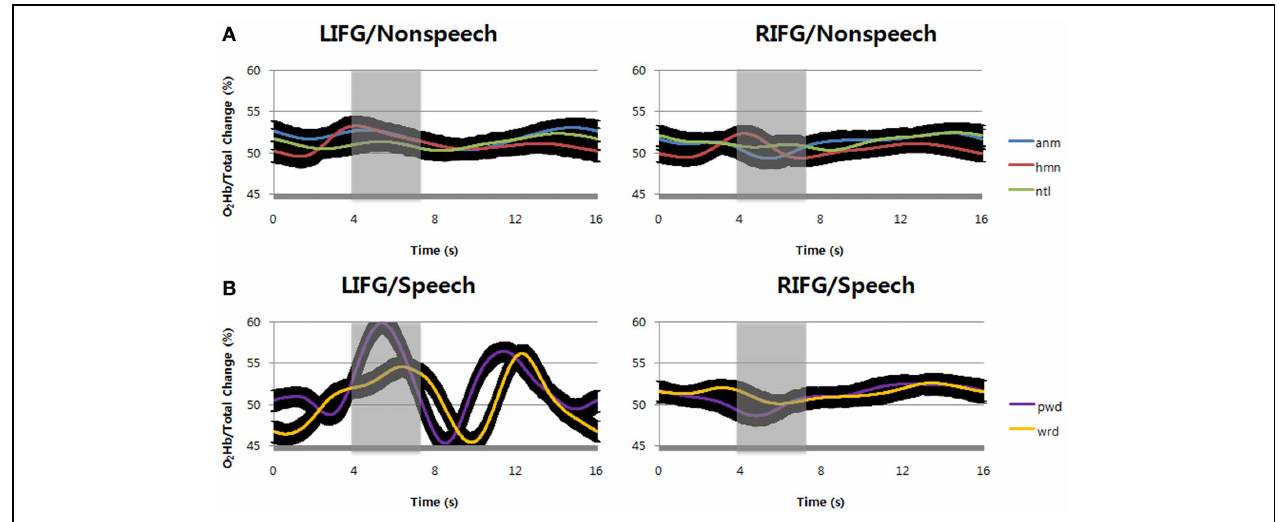
FIGURE 3 | (A) Compared with the value at stimulus onset, the percent change of O 2 Hb over total Hb concentration by passive listening of non-speech sounds, i.e., animal vocalizations, human non-speech sounds, and natural sounds were shown. (B) The percent change of O 2 Hb over total Hb concentration by verbal repetition of